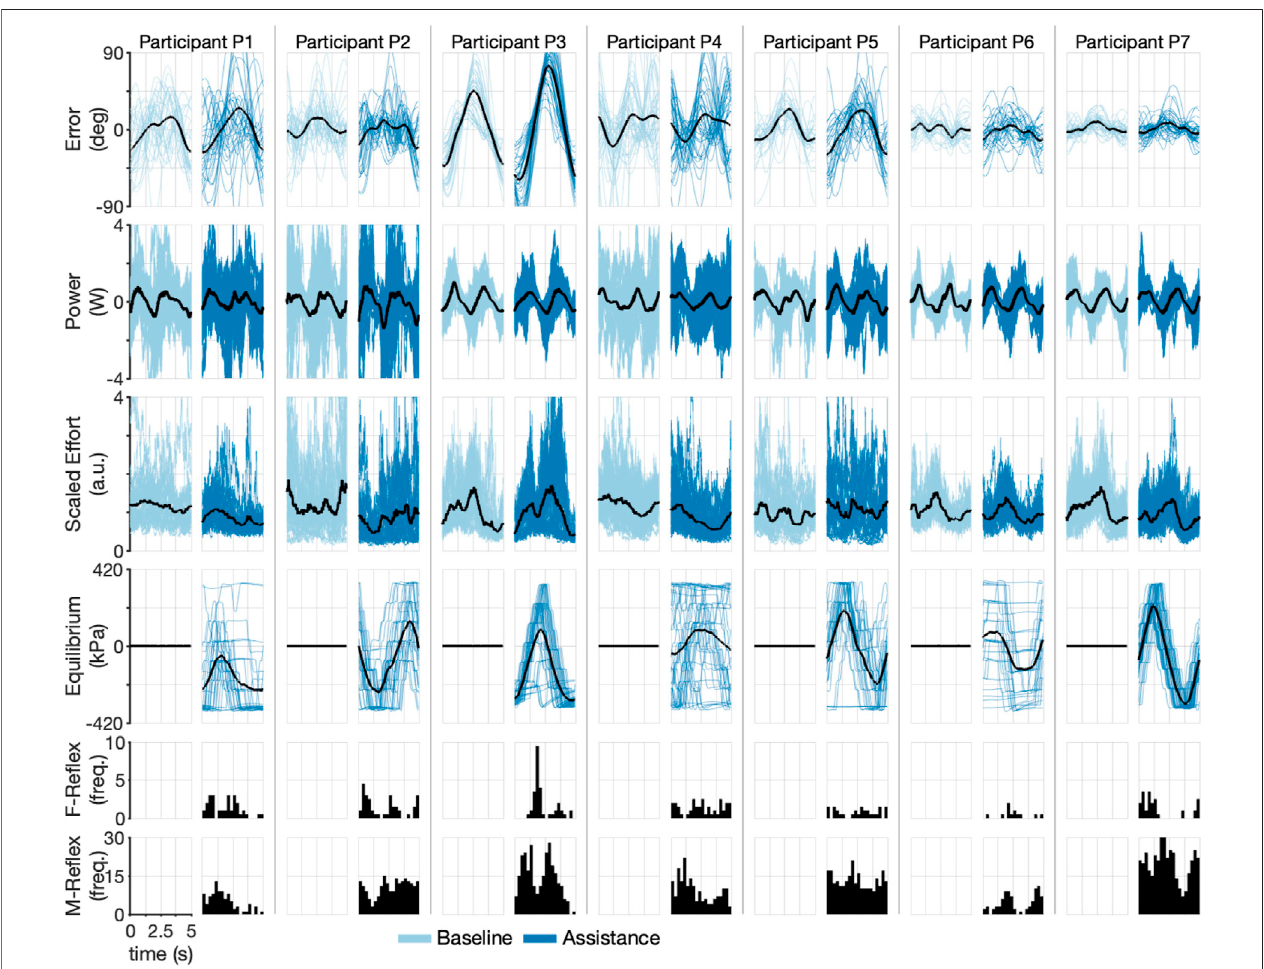
FIGURE 6 | Time-domain experimental results during the Inertia-Dominant environment. Each pair of columns (one for baseline and one for assistance conditions) represents a single participant. Each row shows a different experimental variable. The dark line represents mean. Shaded lines are individual cycles. The last two rows show cycle time histograms (timing of each re fl ex within a cycle) of each type of triggered re fl ex (F-Re fl ex, M-Re fl ex).